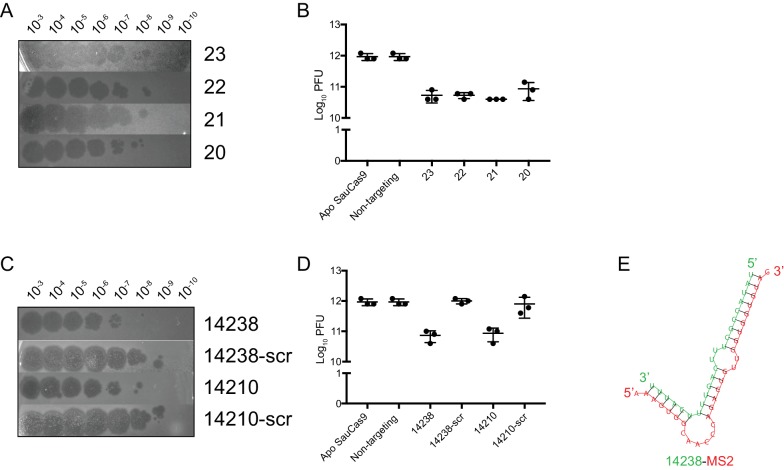
Confirmation that enriched guides from the MS2 screen confer protection against MS2 infection.(A) Representative plaque assay for lawns of E. coli expressing wtSauCas9 and sgRNA of different length spotted with phage dilutions indicated. Here, the sgRNA with the highest fold-change in both MOI-10 and −100 samples was chosen for each length. The 23-mer sgRNA produces hazy plaques for an unknown reason. All other guides tested, including a different 23-mer sgRNA, produced clear plaques. (B) Quantification of relative plaque forming units (PFU, mean ± S.D., n = 3) from data in (A). (C) Same as in (A). Guides were two ‘control’ guides that were significantly enriched in both MOI-10 and −100 treatments during phage selection. Scrambled (scr) indicates random shuffling of the target sequence to serve as a non-targeting control. Scrambled sequences were verified against the MS2 genome and its reverse-complement to ensure no partial matches. (D) Quantification of relative PFU as in (C). Guides 14238 and 14210 confer ~10 fold protection over their scrambled counterparts. The level of protection is similar to perfectly complementary guides (B, and see Figure 3E and F). (E) Predicted binding of guide 14238 (green) to a fragment of the MS2 genome (red, nts: 1533–1563) using RNAhybrid (Rehmsmeier et al., 2004).10.7554/eLife.32724.022Figure 3—figure supplement 3—source data 1.Plaque enumeration for SauCas9-mediated MS2 protection.